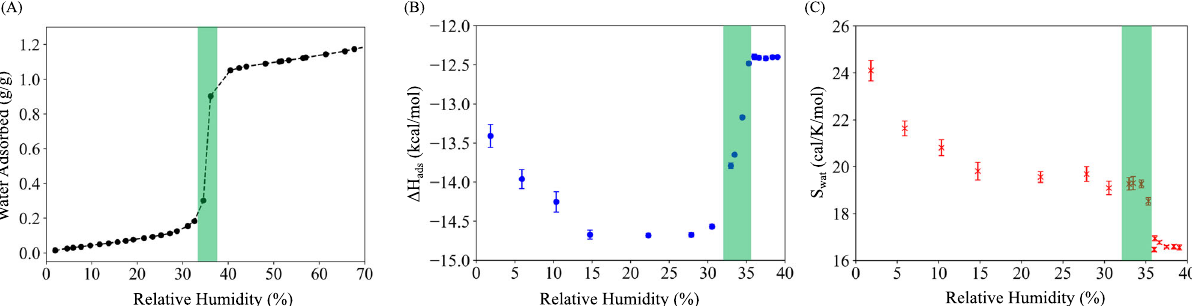
Fig. 1 Thermodynamics of water adsorption in NU-1500-Cr. A Experimental water adsorption isotherm. B Enthalpy of adsorption Δ H ads and ( C ) water entropy S wat at different RHs. Green regions correspond to the adsorption